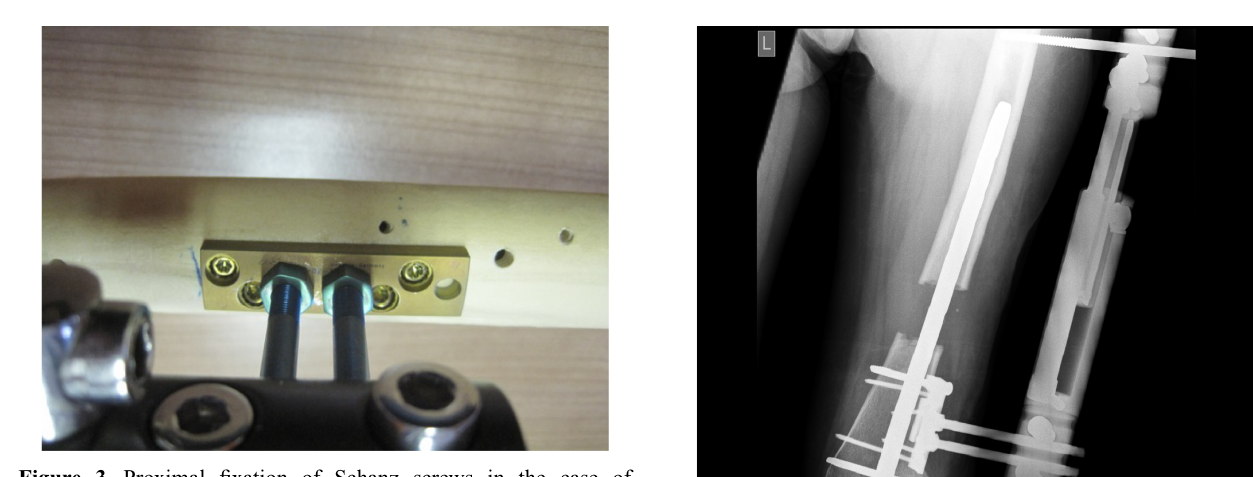
Figure 3. Proximal fixation of Schanz screws in the case of retrograde technique (Figure 1). On the diaphysis one plate of the ONAS-DPS can be used only (distally a wedge subplate must be used in order to compensate for the femoral shape – Figures 1 and 2). Further, no screw should go through the IM nail proximally (in contact with the distal fixation – Figures 1 and 2) as this would prevent elongation. Four angle stability screws and asymmetrically drilled corresponding screw holes are the same as shown in Figure 2.